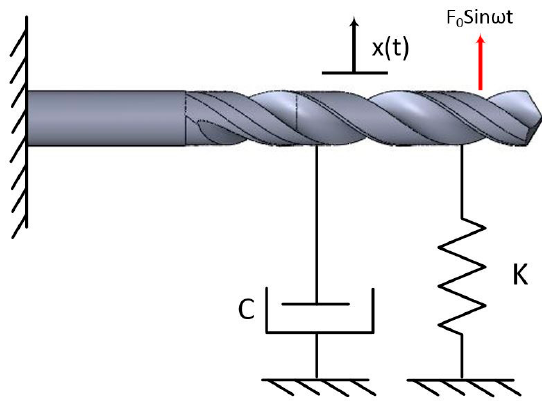
Figure 7. Mass-spring system for the cutting tool.